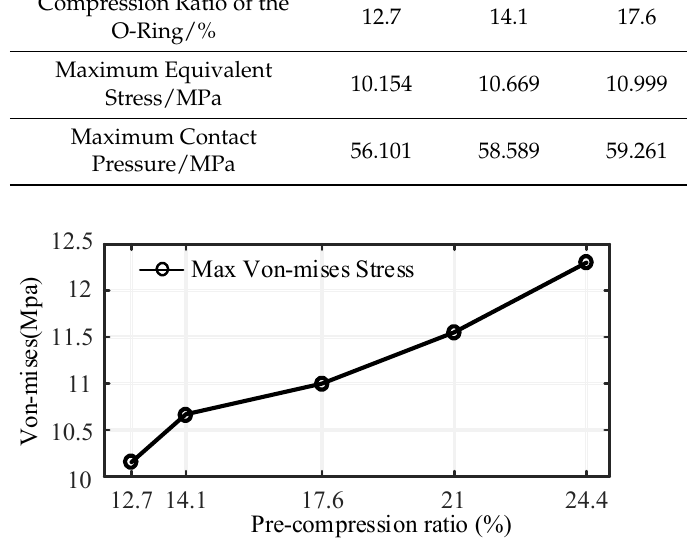
Figure 18. Equivalent stress affected by compression ratio.